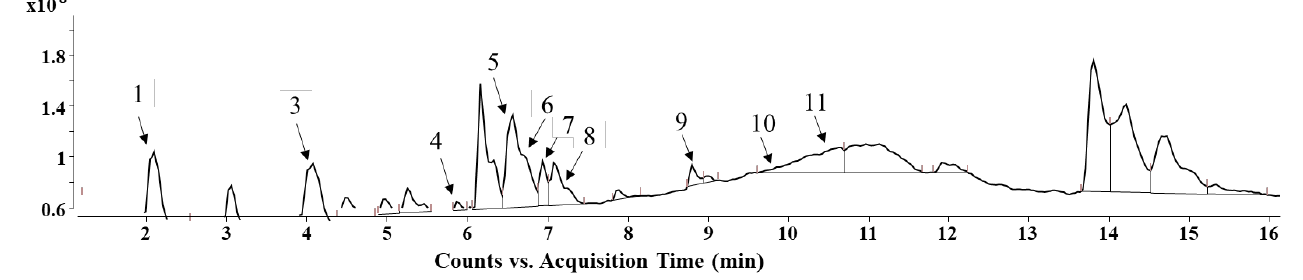
Figure 1. TIC chromatogram of H. delphicum extract. 1 : Neo-chlorogenic acid; 2 : chlorogenic acid; 3 : epicatechin; 4 myricetin glucoside; 5 : rutin; 6 : hyperoside; 7 : isoquercitrin; 8 : quercitrin 9 : I3, II8 bi- apigenin; 10 : amentoflavone; 11 : pseudohypericin.